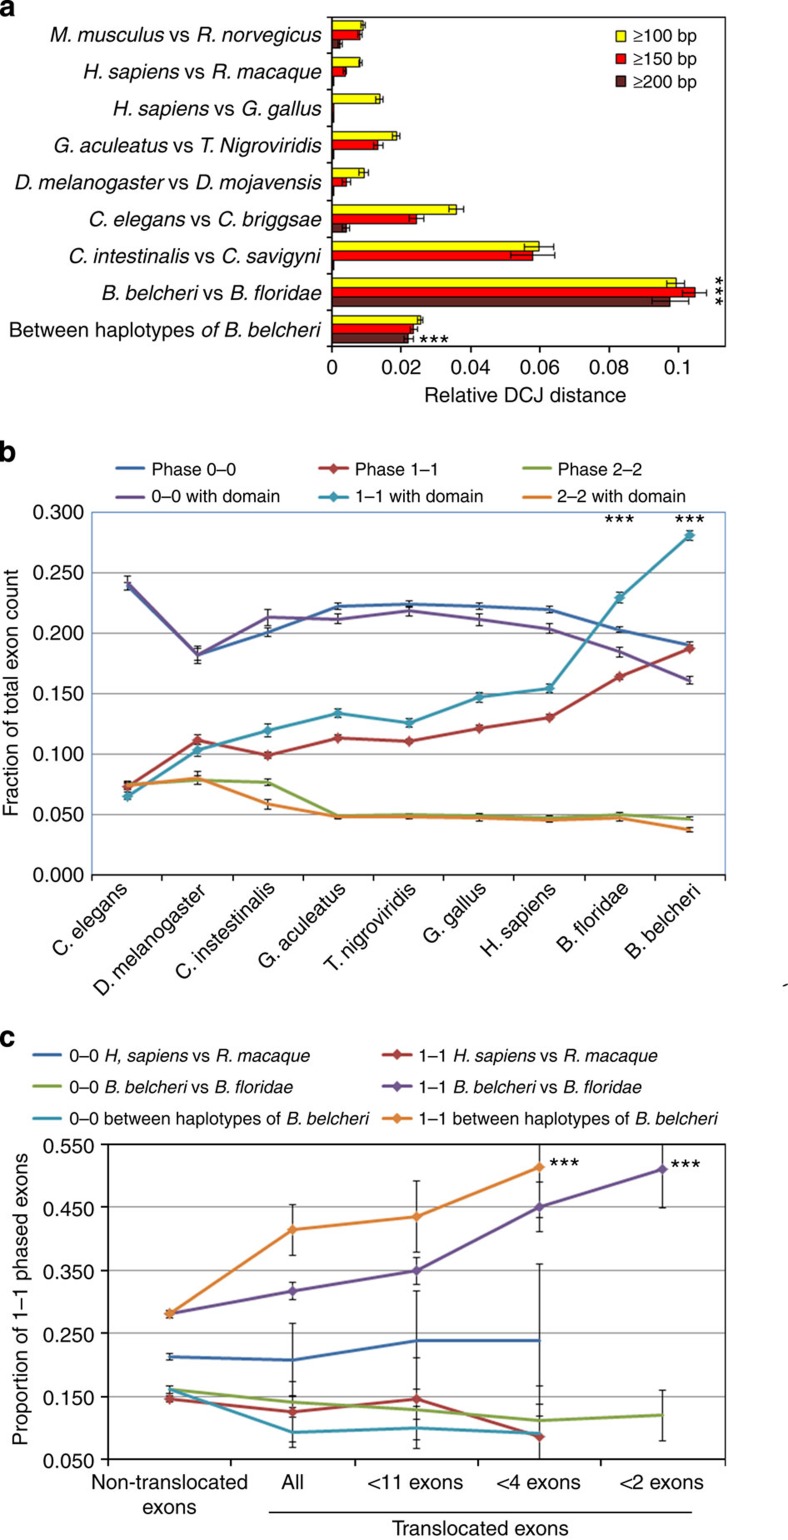
Comparative analysis of exon shuffling and exon phase bias.(a) Comparison of the DCJ distances contributed solely by rearrangements occurring at the subgenic (exon) level in several species pairs. *** indicates significant differences between lancelets and other species pairs (P<1e−16, χ2-test). (b) Comparison of the proportions of internal exon phases 0–0, 1–1 and 2–2 in different species. Only data for exons larger than 100 bp are shown. For all comparisons of 1–1 phased exons between lancelets and other species, P<1e−16 (***; χ2-tests). (c) Comparison of the exon phase biases of non-translocated and translocated domain-containing exons. For all comparisons between non-translocated and translocated 1–1 phased exons in lancelets, P<1e−16 (***; χ2-tests). The error bars show the 95% confidence intervals. More information is provided in Supplementary Note 13.